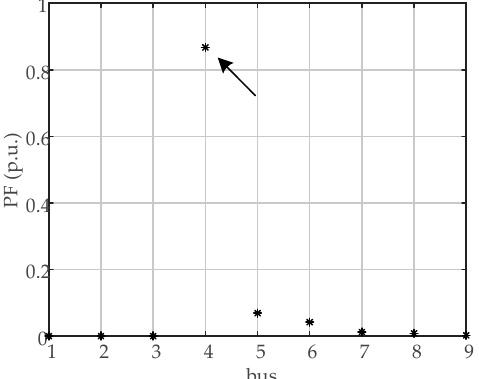
Figure 12. PFs corresponding to the resonance frequency f = 825 Hz.